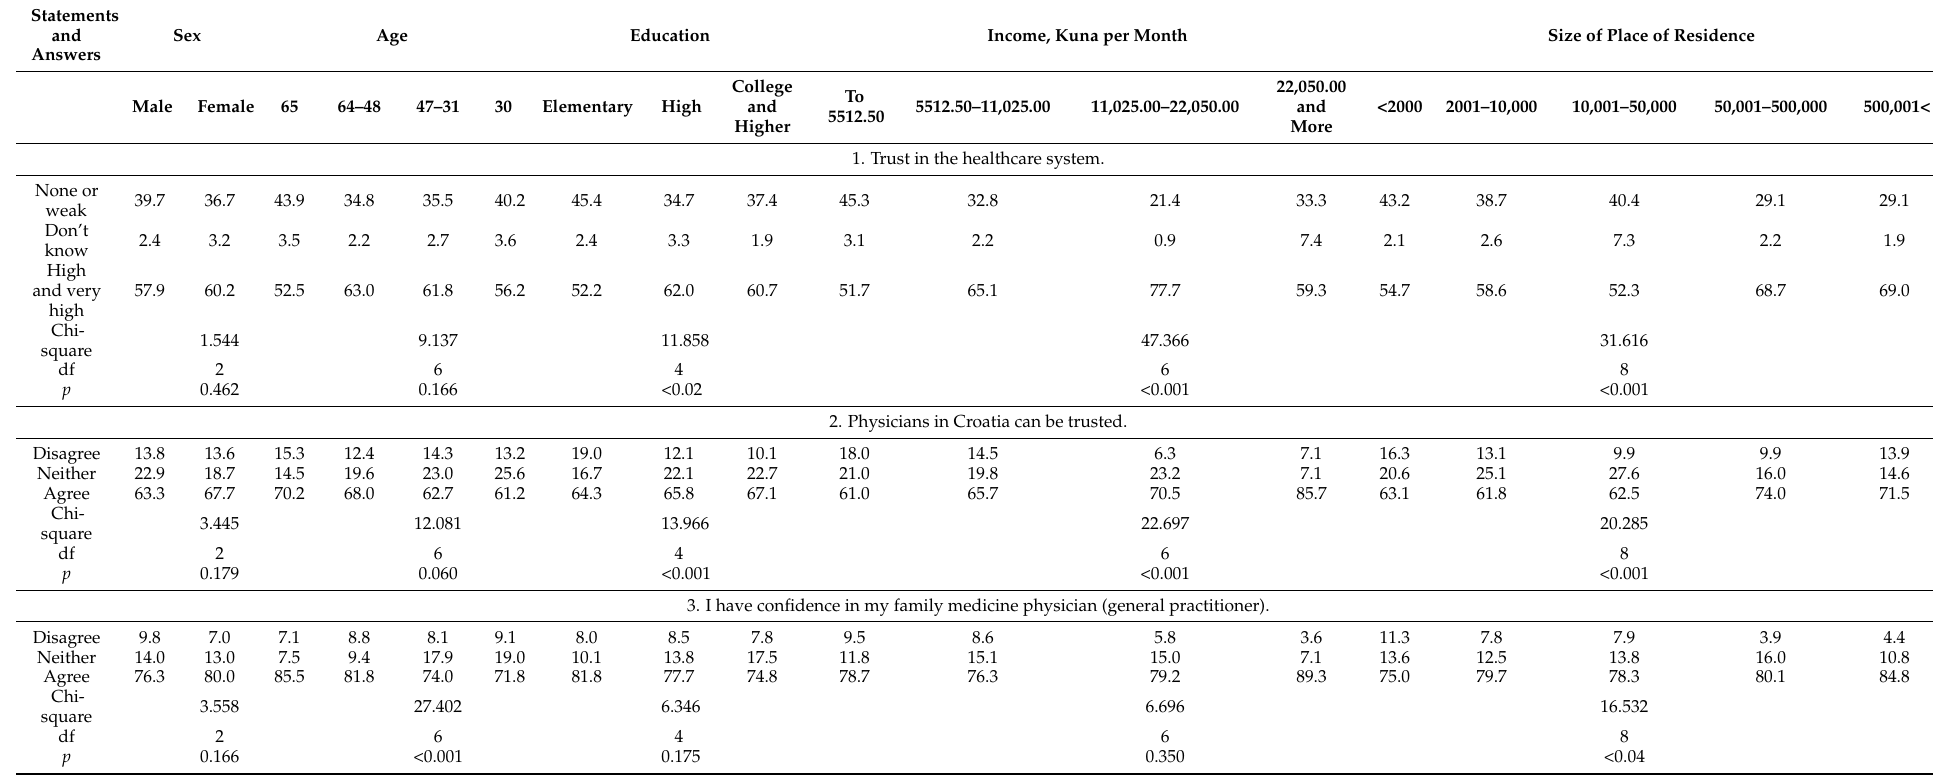
Table 5. Differences in respondents’ answers according to sex, age, education, monthly income, and size of place of residence (chi-square test